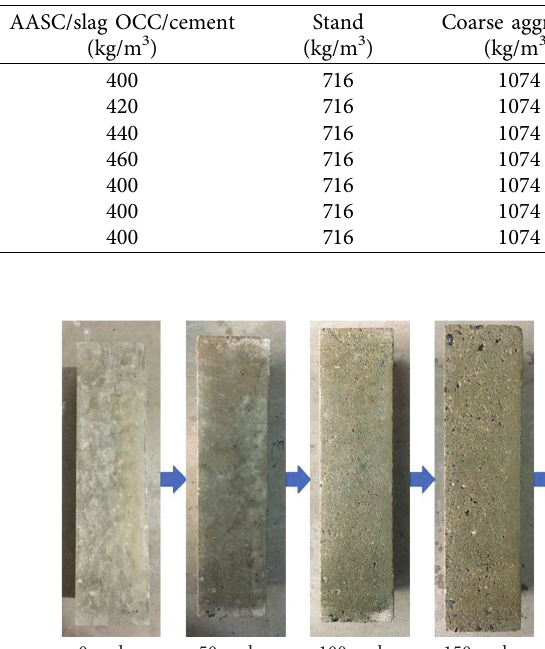
Table 2: Mix proportion of AASC and OCC and 28d compressive